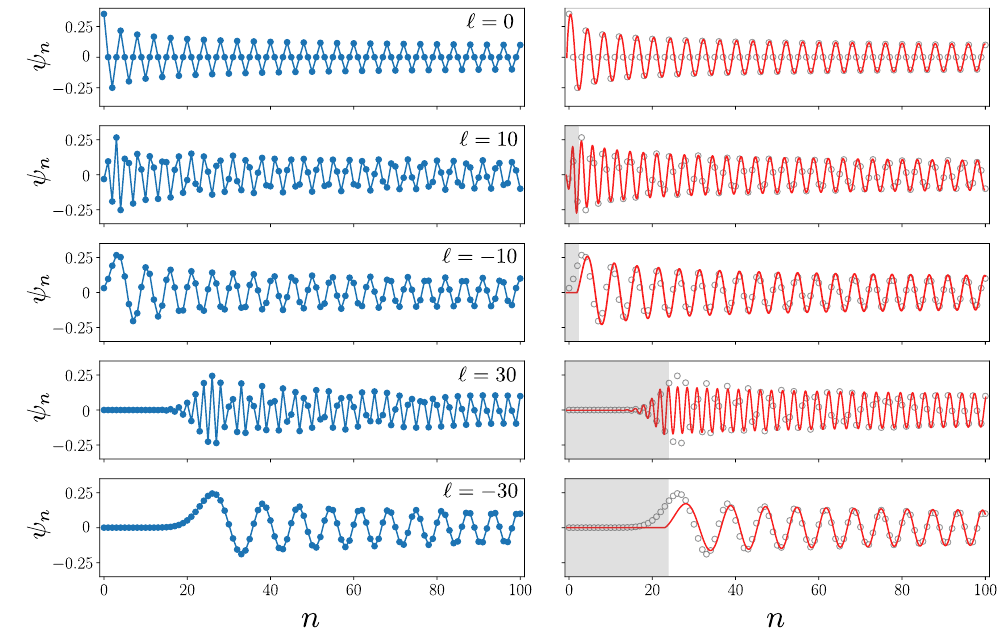
Figure 8: Some of the eigenstates of the lattice model with square-root position de- pendence of the hopping. Left and right panels respectively show the results of exact diagonalization on a lattice with 101 sites, and the corresponding analytical approx- imation given by Eq. (49). The eigenstates are labeled with integer numbers (cid:96) in the range of ( − [ N / 2 ] , [ N / 2 ]) such that the zero mode corresponds to (cid:96) = 0. The energy of states with (cid:96) = ± 10 and (cid:96) = ± 30, are obtained numerically to be (cid:34) = ± 0.31 and (cid:34) = ± 0.97, respectively. For the sake of comparison, the right panels also display the numerical results with empty circles, indicating the good agreement with the approximate analytical functions shown in red solid